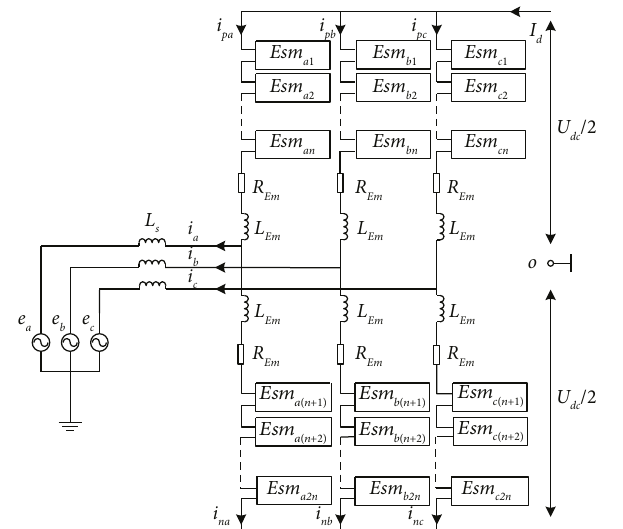
Figure 2: MMC-BESS main circuit